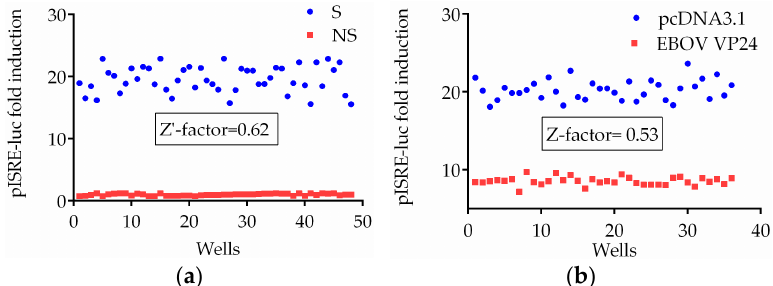
Figure 5. Z ′‐ and Z ‐ factor determination for IFN ‐α stimulation and VP24 inhibition assays. Firefly luciferase activity is normalized to the Renilla luciferase internal control. Results are expressed as pISRE ‐ luc fold induction over the unstimulated control. The Z ′‐ and Z ‐ factor were calculated as described in methods. ( a ) HEK293T cells were seeded in a 96 ‐ well plate and transfected with pISRE ‐ luc (60 ng/well) and pcDNA3.1 (30 ng/well). Twenty ‐ four hours post ‐ transfection, 48 wells (S) were incubated with 1 ng/mL of IFN ‐α and 48 wells were left untreated (NS). ( b ) HEK293T cells seeded in 48 wells were transfected with pISRE ‐ luc (60 ng/well) and pcDNA3.1 (30 ng/well), and those in the remaining 48 wells were transfected with pISRE ‐ luc (60 ng/well) and expression plasmid for VP24 (30 ng/well). Thirty ‐ five wells for each sample were stimulated with 1 ng/mL of IFN ‐α and 12 were not stimulated.